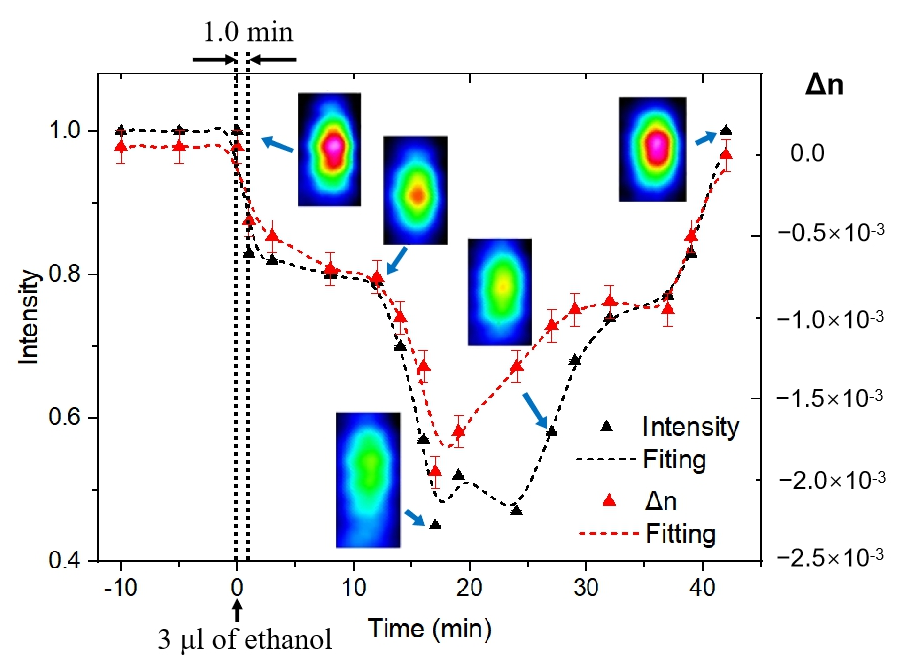
Figure 7. Time dependence of the peak intensity of near-field distribution (black triangle) and the change of the refractive index contrast between core and cladding of waveguides (red triangle) after PG impregnation with 3-µL ethanol liquid.